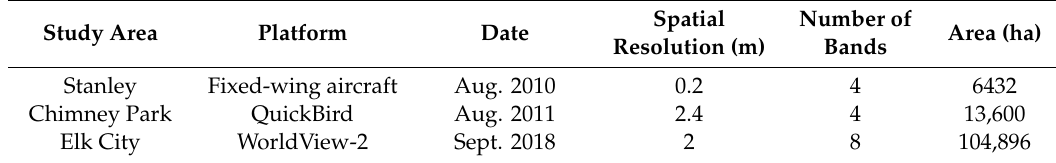
Table 1. Characteristics of high-resolution multispectral imagery for each area.